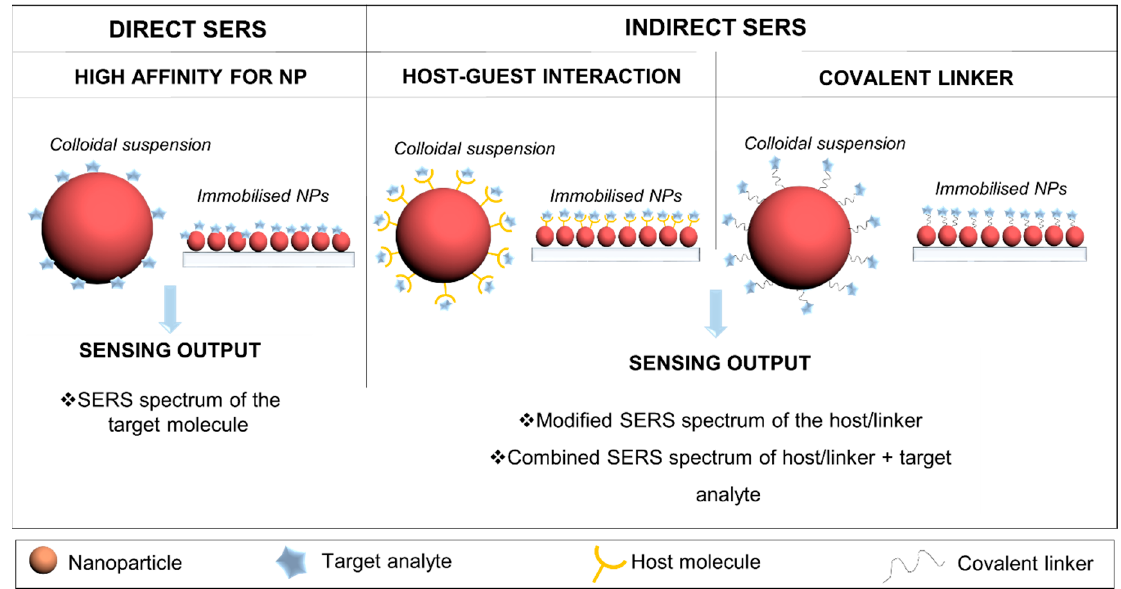
Figure 1. Label-free strategies for surface-enhanced Raman scattering (SERS) detection classified as direct and indirect. The direct detection is used when the target analyte has high affinity to the nanoparticle. Indirect strategies using host molecules or covalent linkers are used to capture analytes with low affinity for the nanoparticle with high specificity.